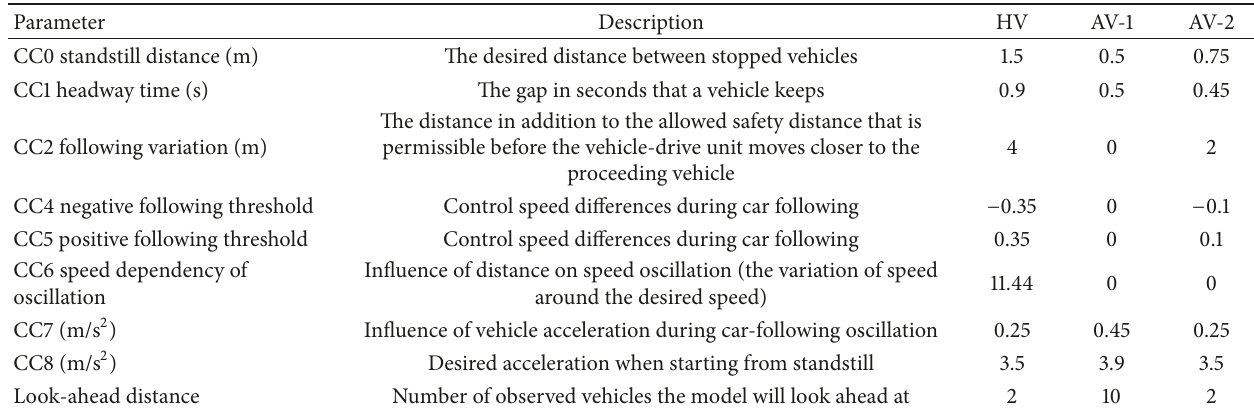
Table 1: Parameters for HV and AV behaviours.